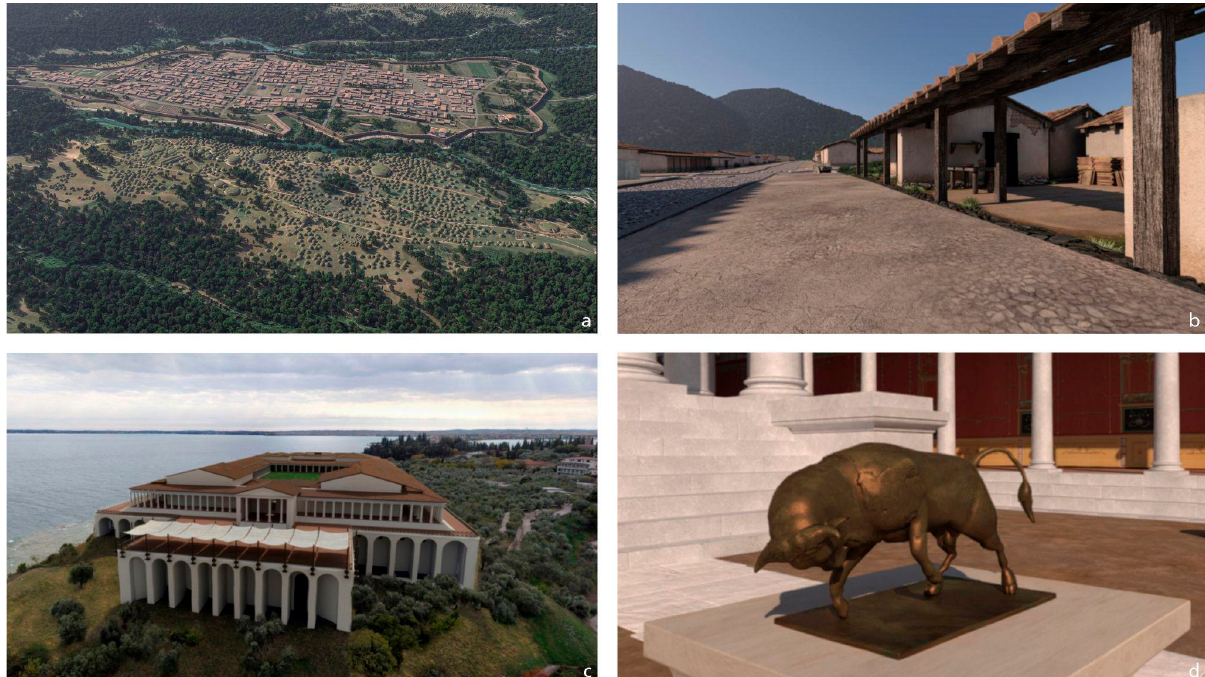
Figure 5. Examples of reconstructions at different scales: ( a ) ancient landscape of Cerveteri (by Progetto Katatexilux); ( b ) city of Kainua (by Progetto Katatexilux); ( c ) villa of Sirmione on Lake Garda (by Carraro Lab); ( d ) Toro Cozzante of Sibari (by Altair4 Multimedia and Superelectric).